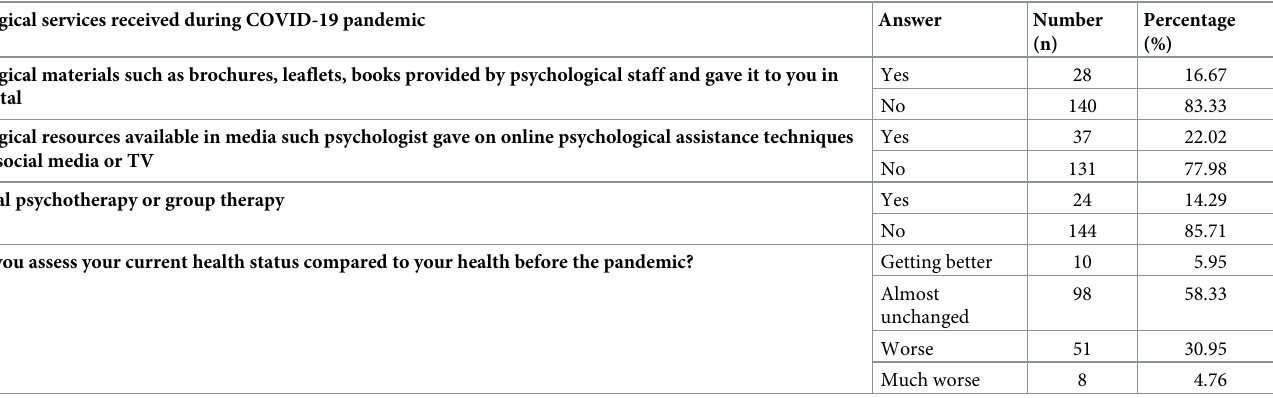
Table 4. Available resources of mental healthcare services during pandemic.